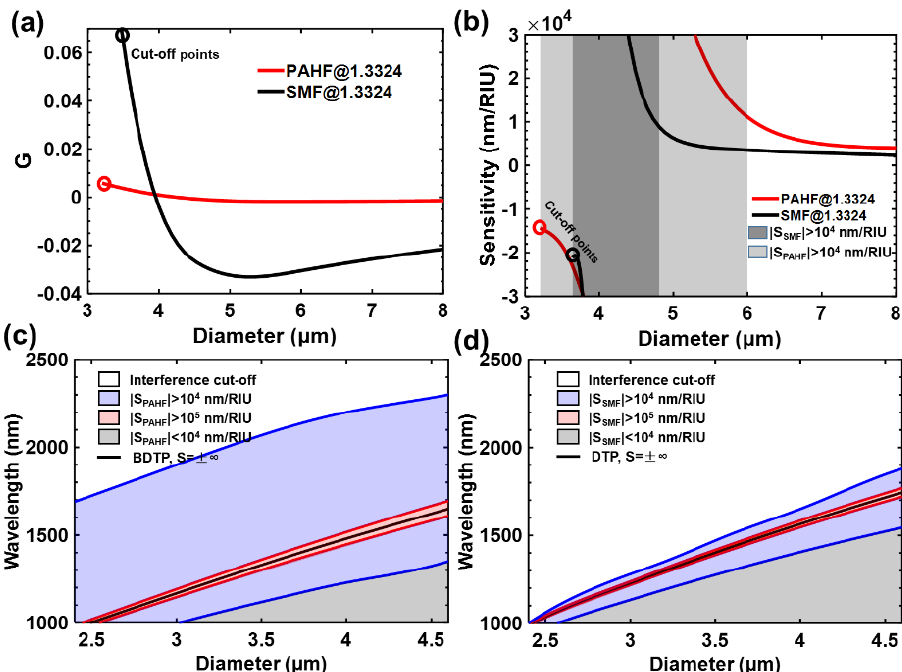
Figure 6. ( a ) Group birefringence G and ( b ) calculated sensitivity for PAHF and SMF microfibers with different diameters. ( c , d ) RI sensitivity and interference cutoff regions of PAHF and SMF microfibers, respectively.